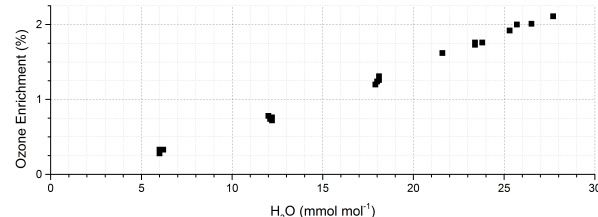
Fig. 6. Increase in the ozone signal from the removal of water vapor molecules by the Nafion dryer as a function of the water vapor mole fraction in the sample air, using the drying efficiency ratios shown in Fig.